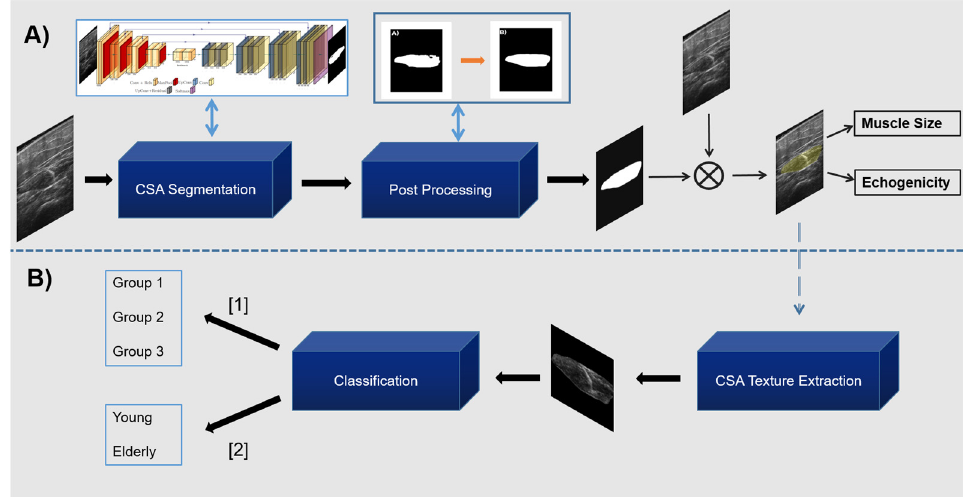
Figure 5. In ( A ), the flowchart of the proposed pipeline to extract the CSA and its mean grey level (echogenicity) is presented. In ( B ), the two classification analyses from the predicted CSA texture are depicted.